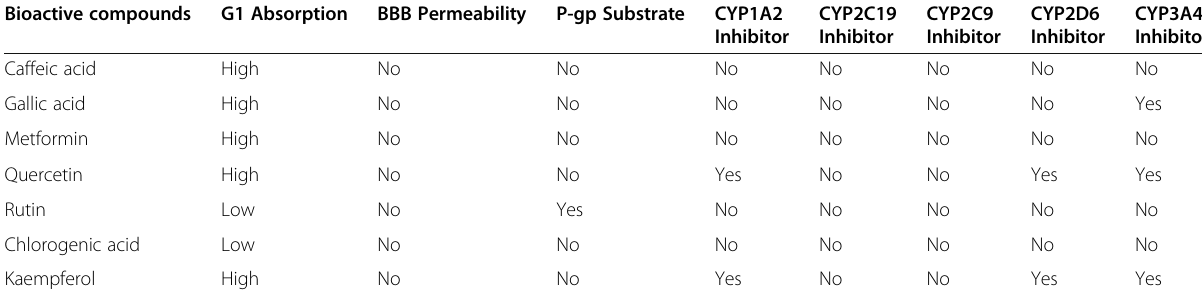
Table 3 ADMET distribution profiles of the six bioactive compounds Bioactive compounds